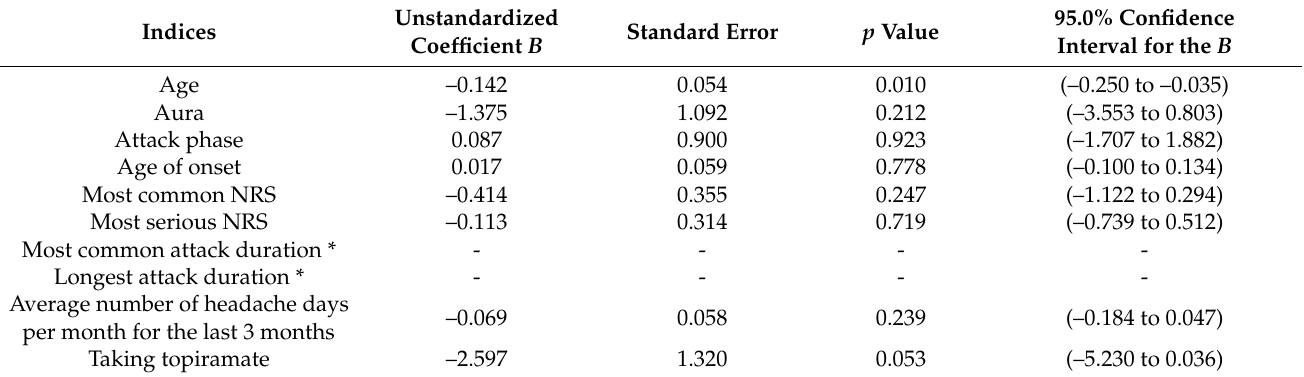
Table 8. Multiple linear regression analysis of the factors influencing the MoCA total score in